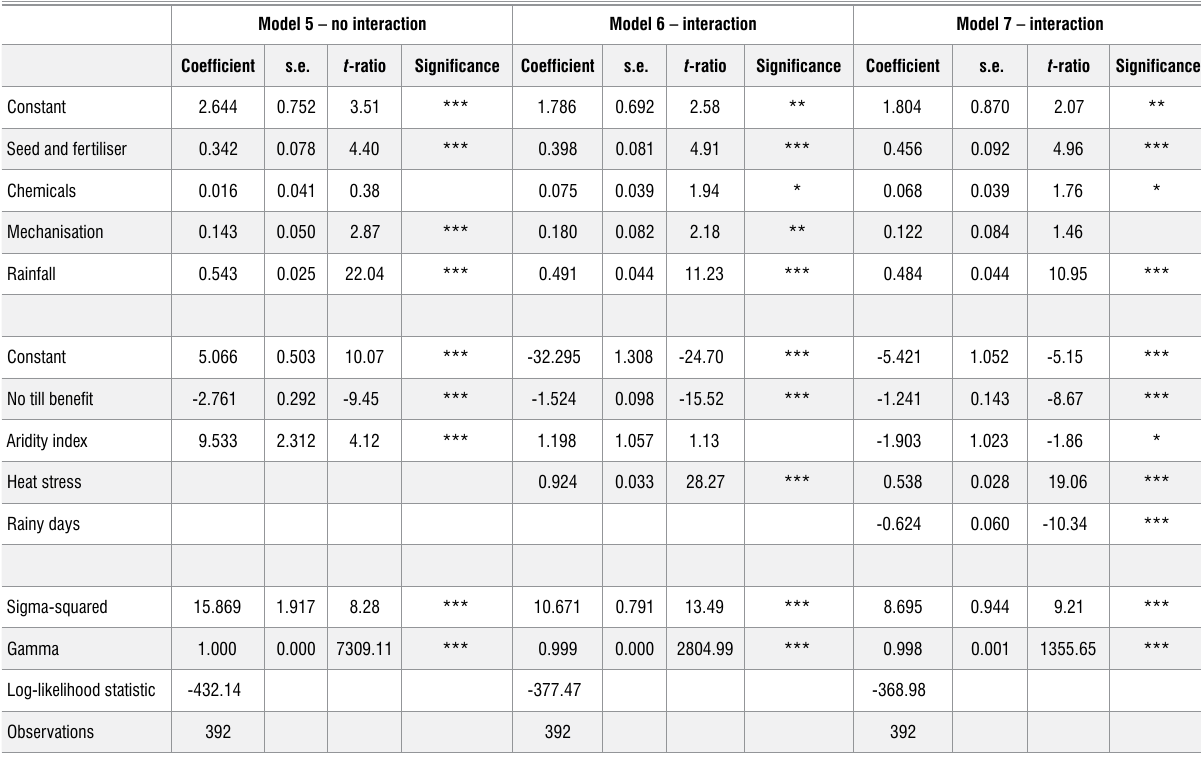
Grain productivity model with aridity